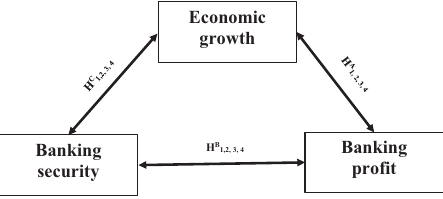
Figure 1. Expected